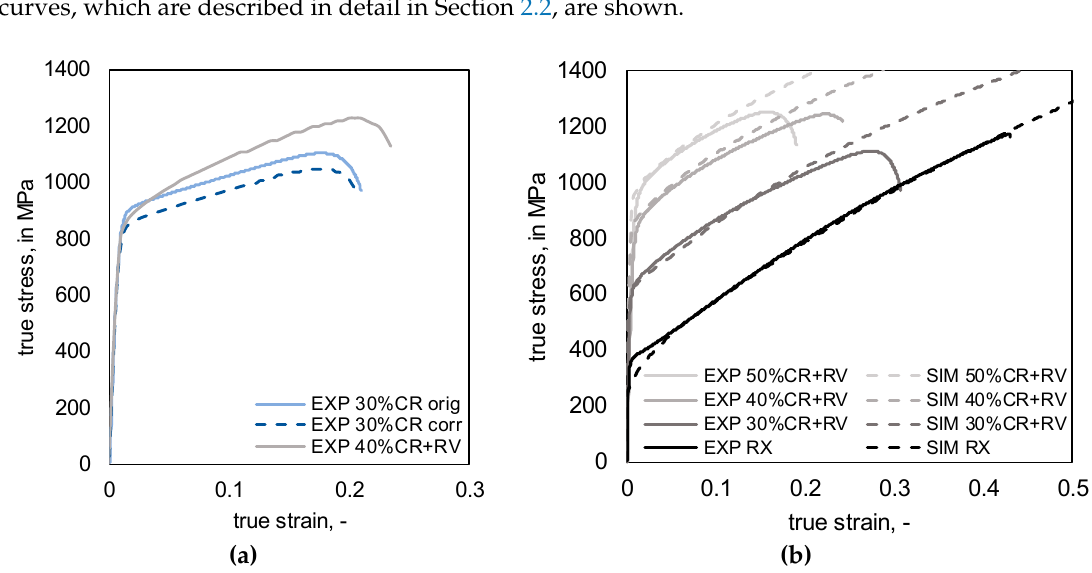
annealing with di ff erent yield strength are illustrated in Figure 3b. Moreover, simulated stress–strain curves, which are described in detail in Section 2.2, are shown.